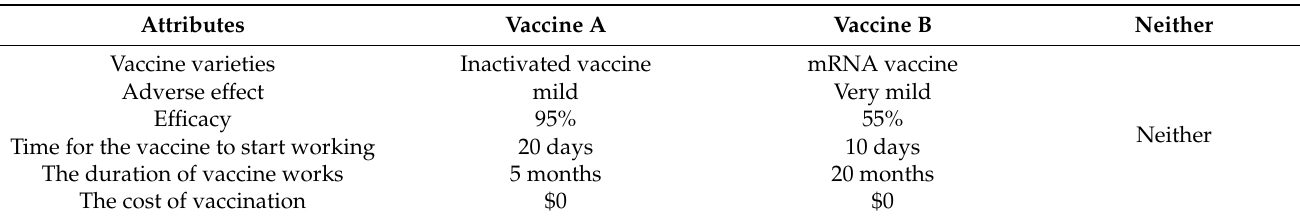
Table 2. An example scenario of the choice-based conjoint in the questionnaire; scenario #1/11. Attributes Vaccine A Vaccine B Vaccine